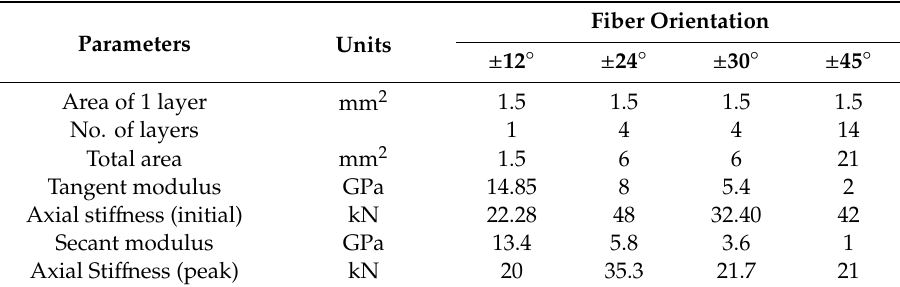
Table 4. Axial sti ff ness ratios as a percentage for layers with di ff erent fiber orientations in the multi-angled 3D-printed GFRP composite specimens (Set 2).